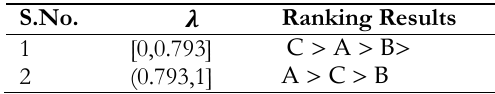
Table 4. Ranking of IFN’s for values of